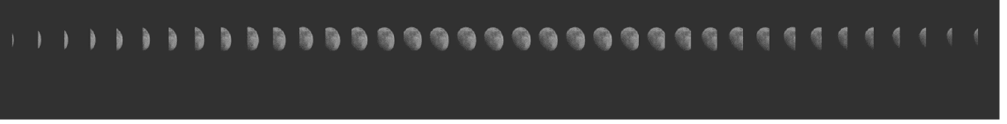
Figure 2. Moon images captured by FY-3D/MERSI (Band 1; 29 December 2017).